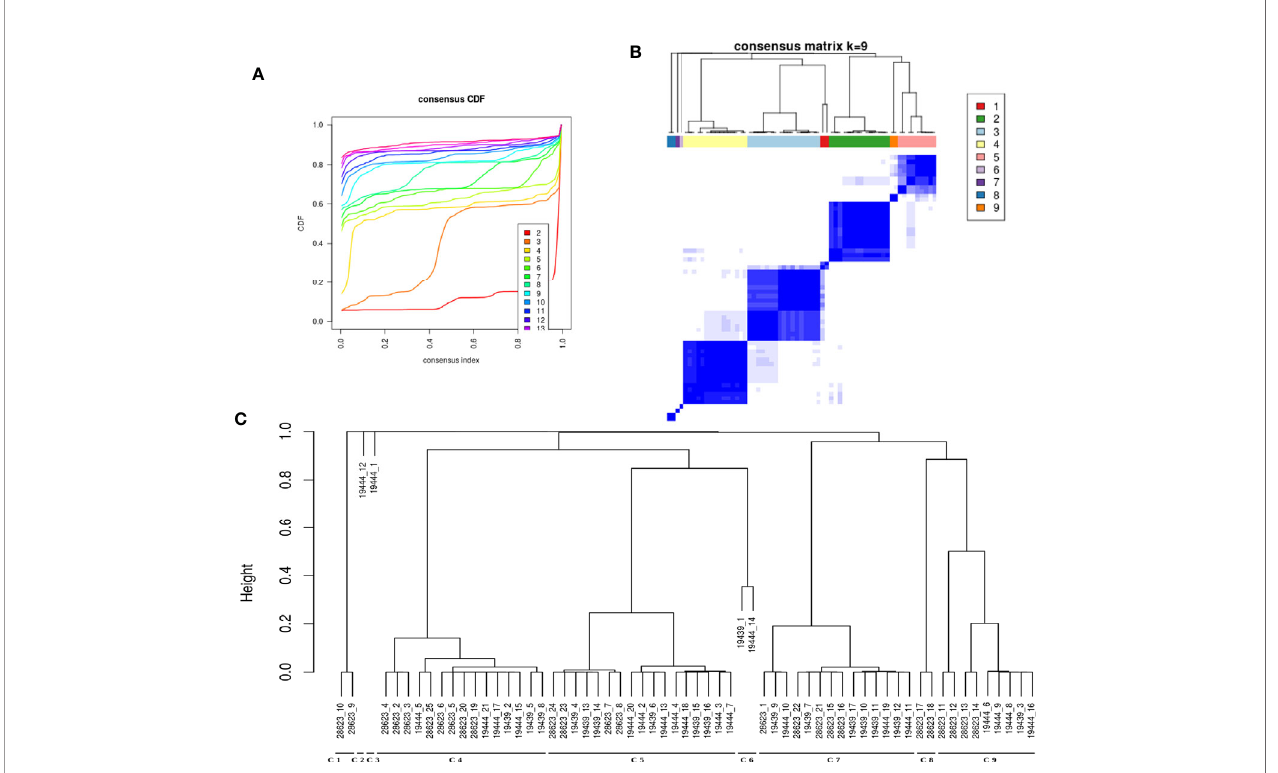
FIGURE 3 | LTBI samples can be divided into groups based on pathway perturbation. (A, B) The LTBI samples can be divided into 9 substantially stable clusters based on their pathway perturbation patterns. The cumulative distribution function (CDF) plot shows that CDF reaches an approximate maximum as early as k=9 cluster. The clusters are signi fi cantly different from each other. 4 of the clusters contain the majority of the samples, whereas the few other samples show a highly varied pathway pro fi le. (C) The dendrogram shows the samples in each cluster. The clustering was not biased by cohort or dataset as each of the large clusters contains samples from different